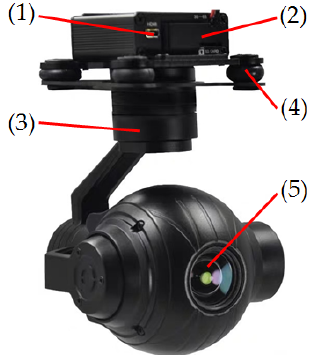
Figure 3. 3-axis gimbaled camera. (1) the output port of the video stream; (2) the embedded stabilization controller; (3) the brushless DC motor with magnetic rotary encoder; (4) the vibration damper; (5) the camera.